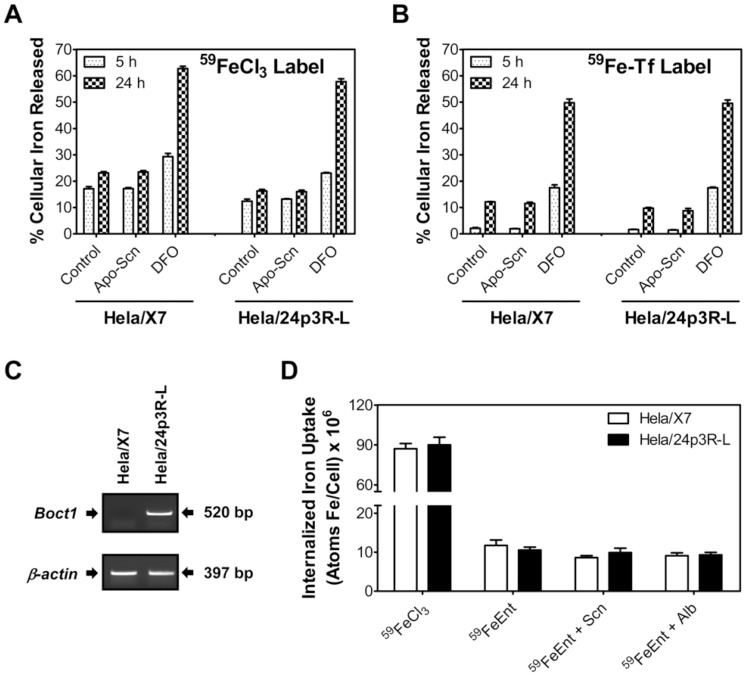
Scn has no effect on iron release or iron uptake from HeLa cells.Control HeLa/X7 (transfected with empty vector) or HeLa/24p3R-L cells were labeled with either (A) 2.5 µM 59FeCl3 or (B) 0.75 µM 59FeTf and re-incubated with 2 µM murine Scn or control medium for 5 h (dotted columns) or 24 h (checked columns); 100 µM DFO was used as a positive control. Expression of BOCT in transfected HeLa/24p3R-L cells was confirmed by RT-PCR (C). In (C), a typical result from three experiments is shown. In (D), control HeLa/X7 (white columns) and HeLa/24p3R-L cells (black columns) were incubated for 4 h in the presence of 2 µM 59FeCl3, 2 µM 59FeEnt, 2 µM murine Scn with bound 59FeEnt (59FeEnt+Scn) or in the presence of 2 µM 59FeEnt plus 2 µM human albumin (59FeEnt+Alb). Internalized 59Fe was determined by γ-counting. Albumin was added in (D) as an additional control for non-specific binding. Error was calculated as the standard deviation among three experiments.